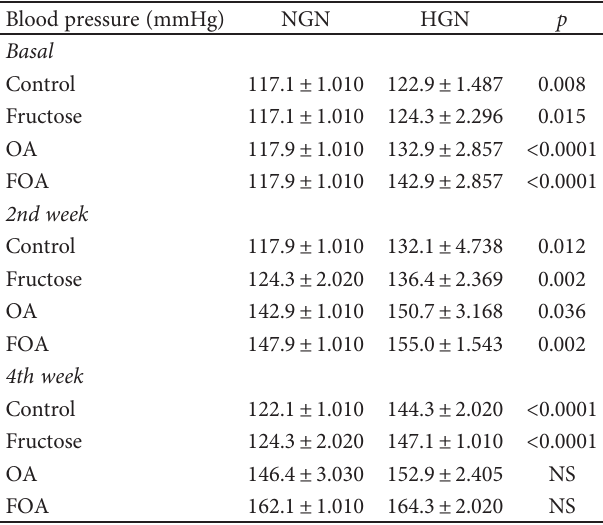
Table 2: Blood pressure. Comparative e ff ect of the gonadal state at di ff erent stages of